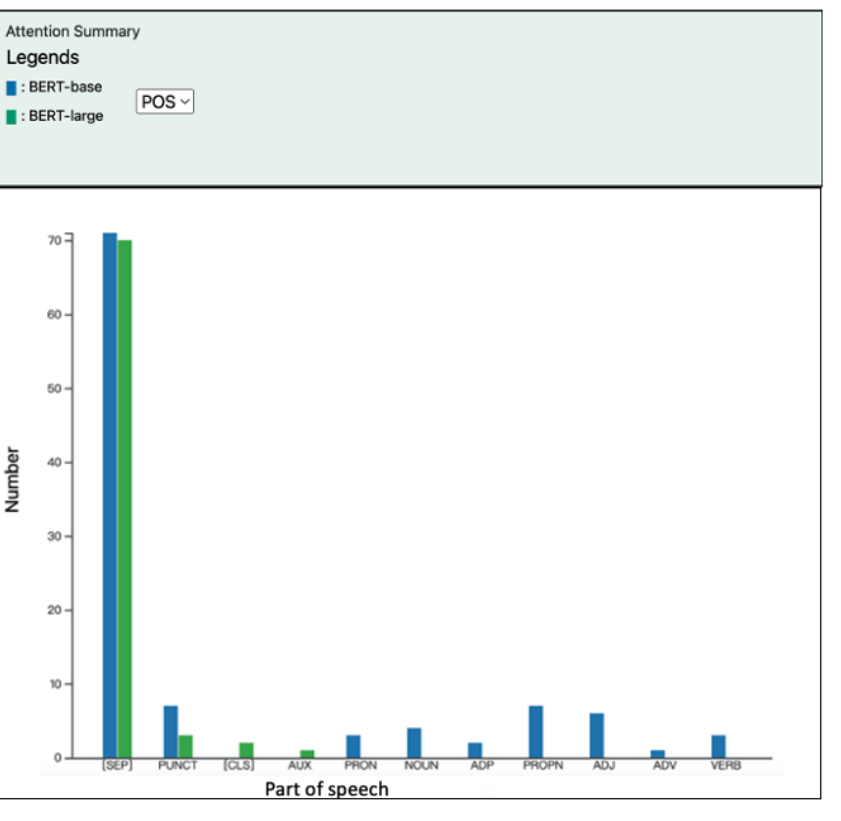
Figure 24. [SEP] dominates the attention words in both models.